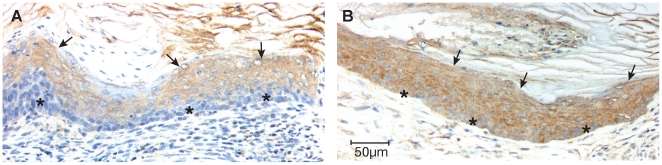
TOPGAL is expressed in ATF3-induced tumors.Immunohistochemistry was used to analyze expression of bacterial β-galactosidase in mammary tumors from mice of genotype: A, BK5.ATF3Tg/0;TOPGAL0/0 or B, BK5.ATF3Tg/0;TOPGALTg/0. Arrows, supra-basal tumor cells; asterisks, basal tumor cells.